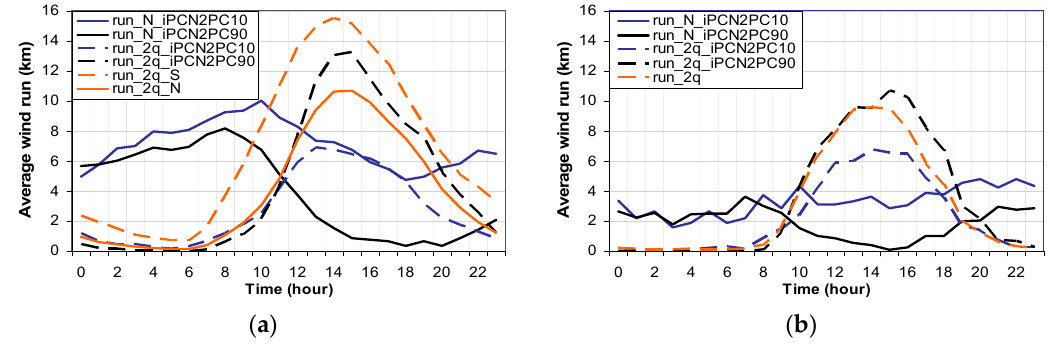
Figure 9. ( a ) For Ebro Observatory, average hourly wind run for iPCN2 < 10th percentile (run_N in blue line and run_2q in blue dashed line) and for iPCN2 > 90th percentile (run_N in black line and run_2q in black dashed line. Run_N corresponds to the wind run of the wind with positive northerly component and run_2q to the wind run of the second quadrant wind), average run_2q in Southern days (orange dashed line) and average run_2q in Northern days (orange line). The average hourly wind run was computed by dividing for each hour, the integration of the wind run from one specific direction throughout the days of each sample and the number of days of that sample. ( b ) The same for Valencia but here it is shown the average run_2q (orange dashed line) of the whole set of days.